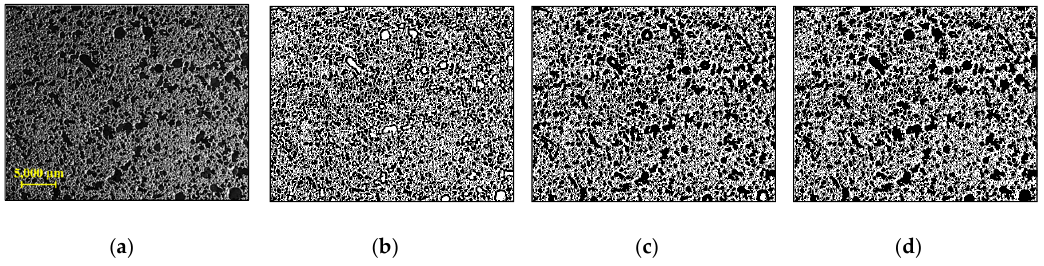
Figure 6. PCM3-3: ( a ) microscopic image; ( b – d ) binary images using 50 × 50, 100 × 100, and 200 × 200 windows, respectively.